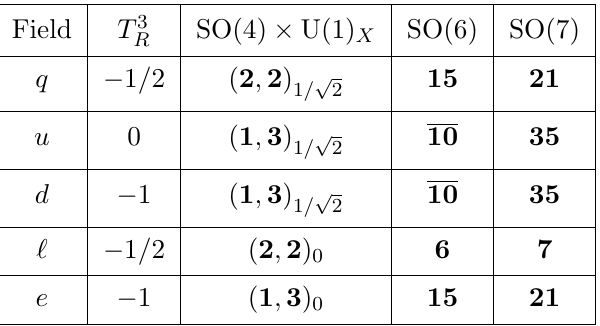
Table 1 . Transformation properties and embedding of elementary fermions into the representations of the fermion resonances they mix